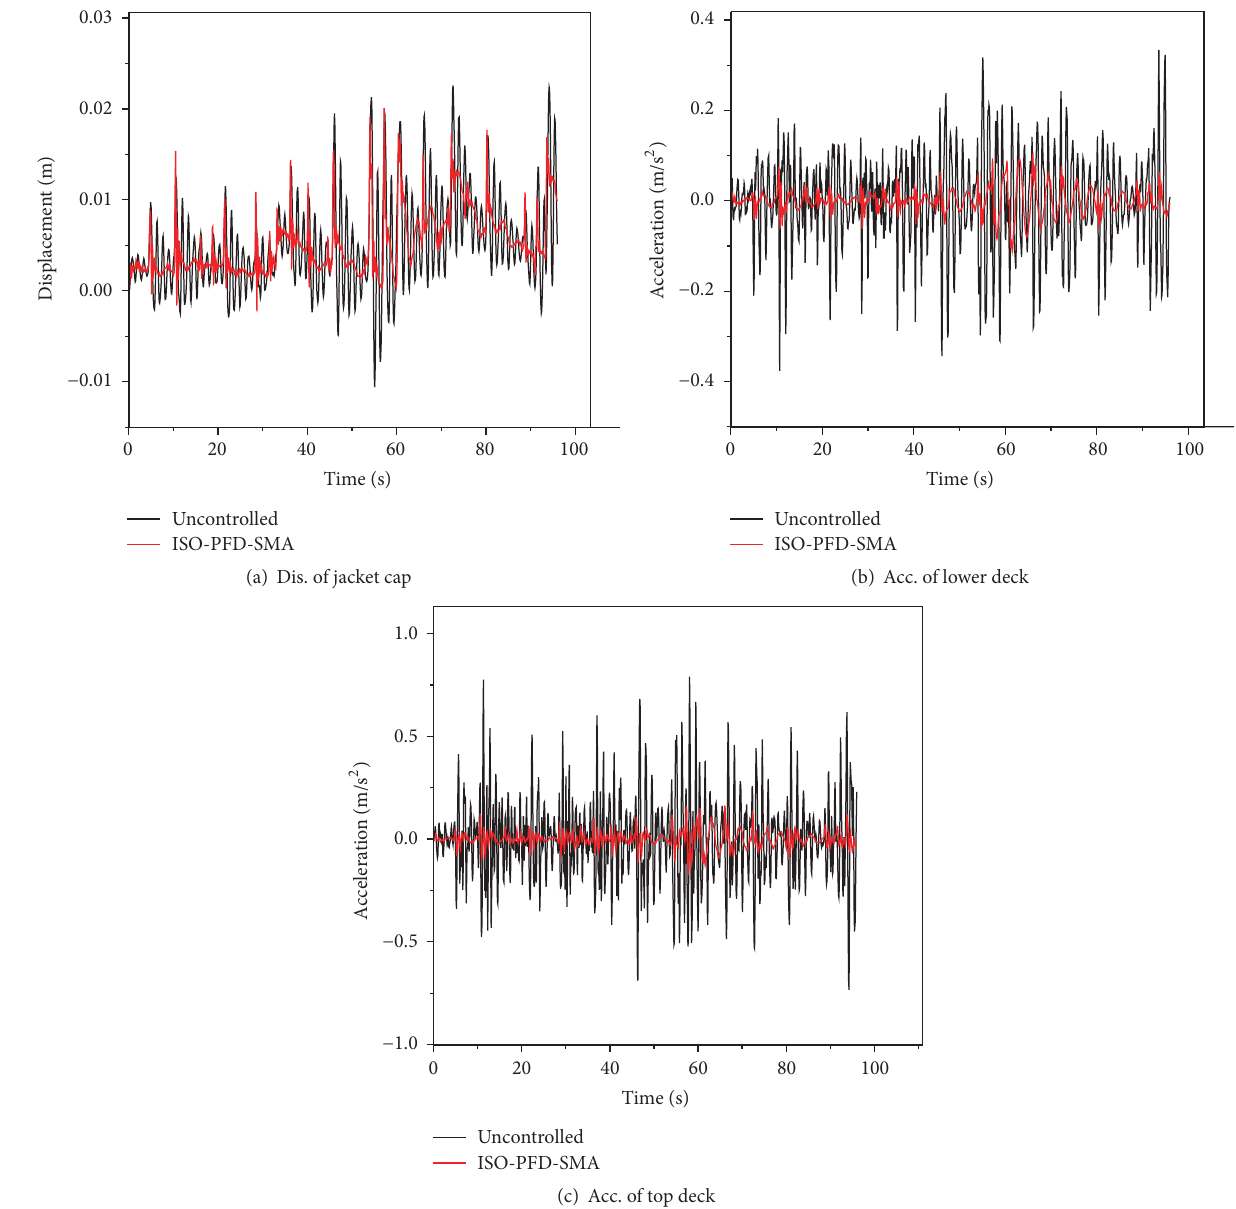
Figure 17: Time history curves of platform structure under bending ice.